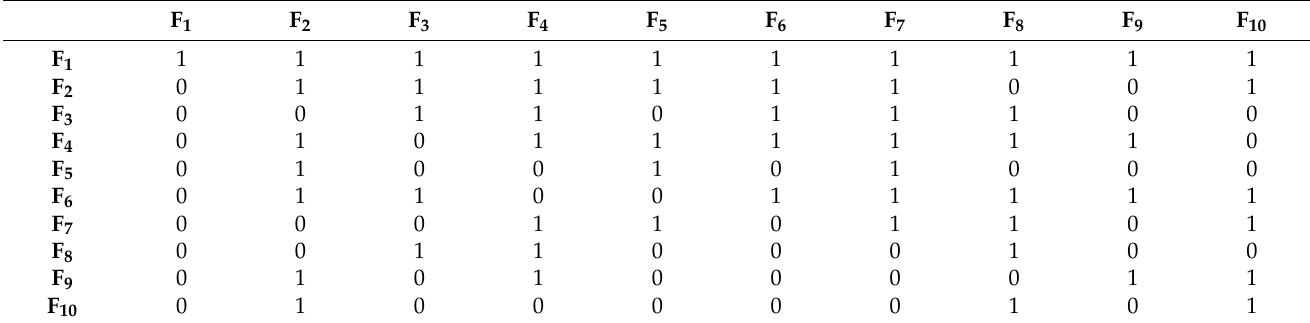
Table 9. Initial reachability matrix.